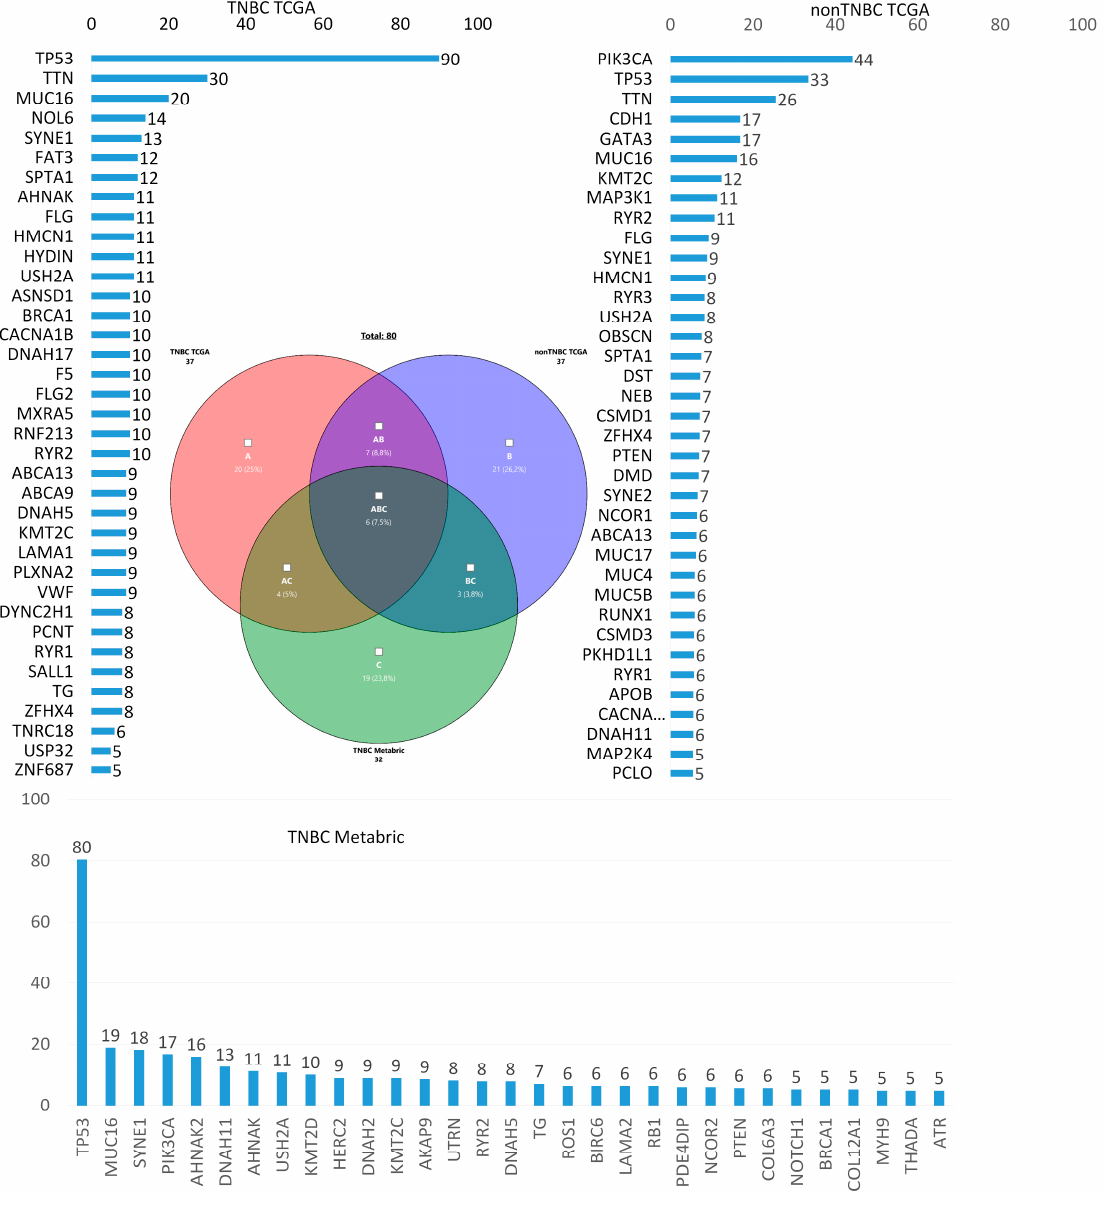
Figure 1. Frequencies of mutations in tumors of patients with TNBC from TCGA, non-TNBC TCGA, and TNBC Metabric. Table 2. Genes whose mutations occur in TNBC and are not found in non-TNBC and the pathways of these genes according to TCGA